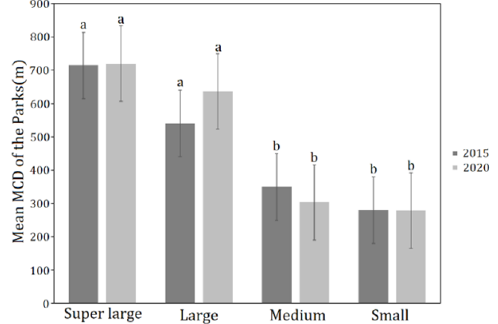
Figure 9. Differences in mean MCD of the parks in two periods for different park groups. Bars and line error represent mean ± standard deviation (S.D.). Lowercase letters indicate significant differences ( p < 0.05) among park groups (the same below).